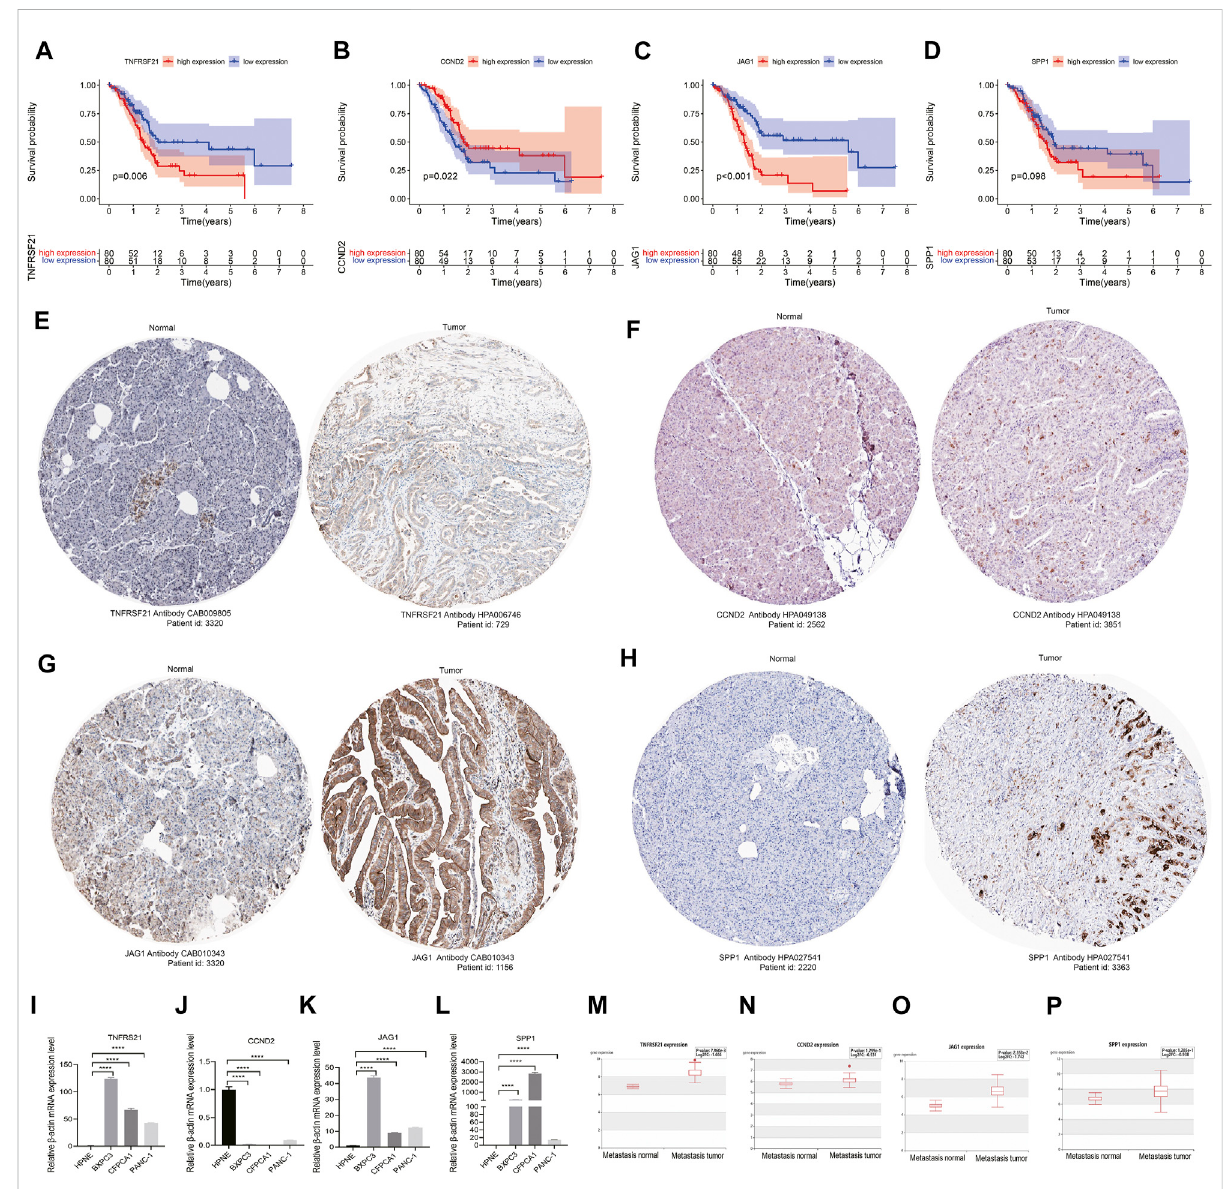
FIGURE 5 Validation of angiogenesis-associated risk genes in PC: (A – D) Survival analyses of four signature genes; (F – H) The histological expression of four signature genes from HPA database. The top of the fi gure indicates the category of tissue specimen. The name of angiogenesis gene, the antibody type used in immunohistochemistry, and the patient ID of tissue specimens are shown at the bottom of each image; (I – L) qRT-PCR analyses of the mRNA expression levels of angiogenesis-associated risk genes in PC cell lines (BXPC-3, CFPAC-1, and PANC-1) and normal pancreas cells (HPNE). (M – P) Correlation of angiogenesis-associated risk genes with tumor metastasis in PC. **** p < 0.0001 by repeated measures with two-tailed unpaired Student ’ s t